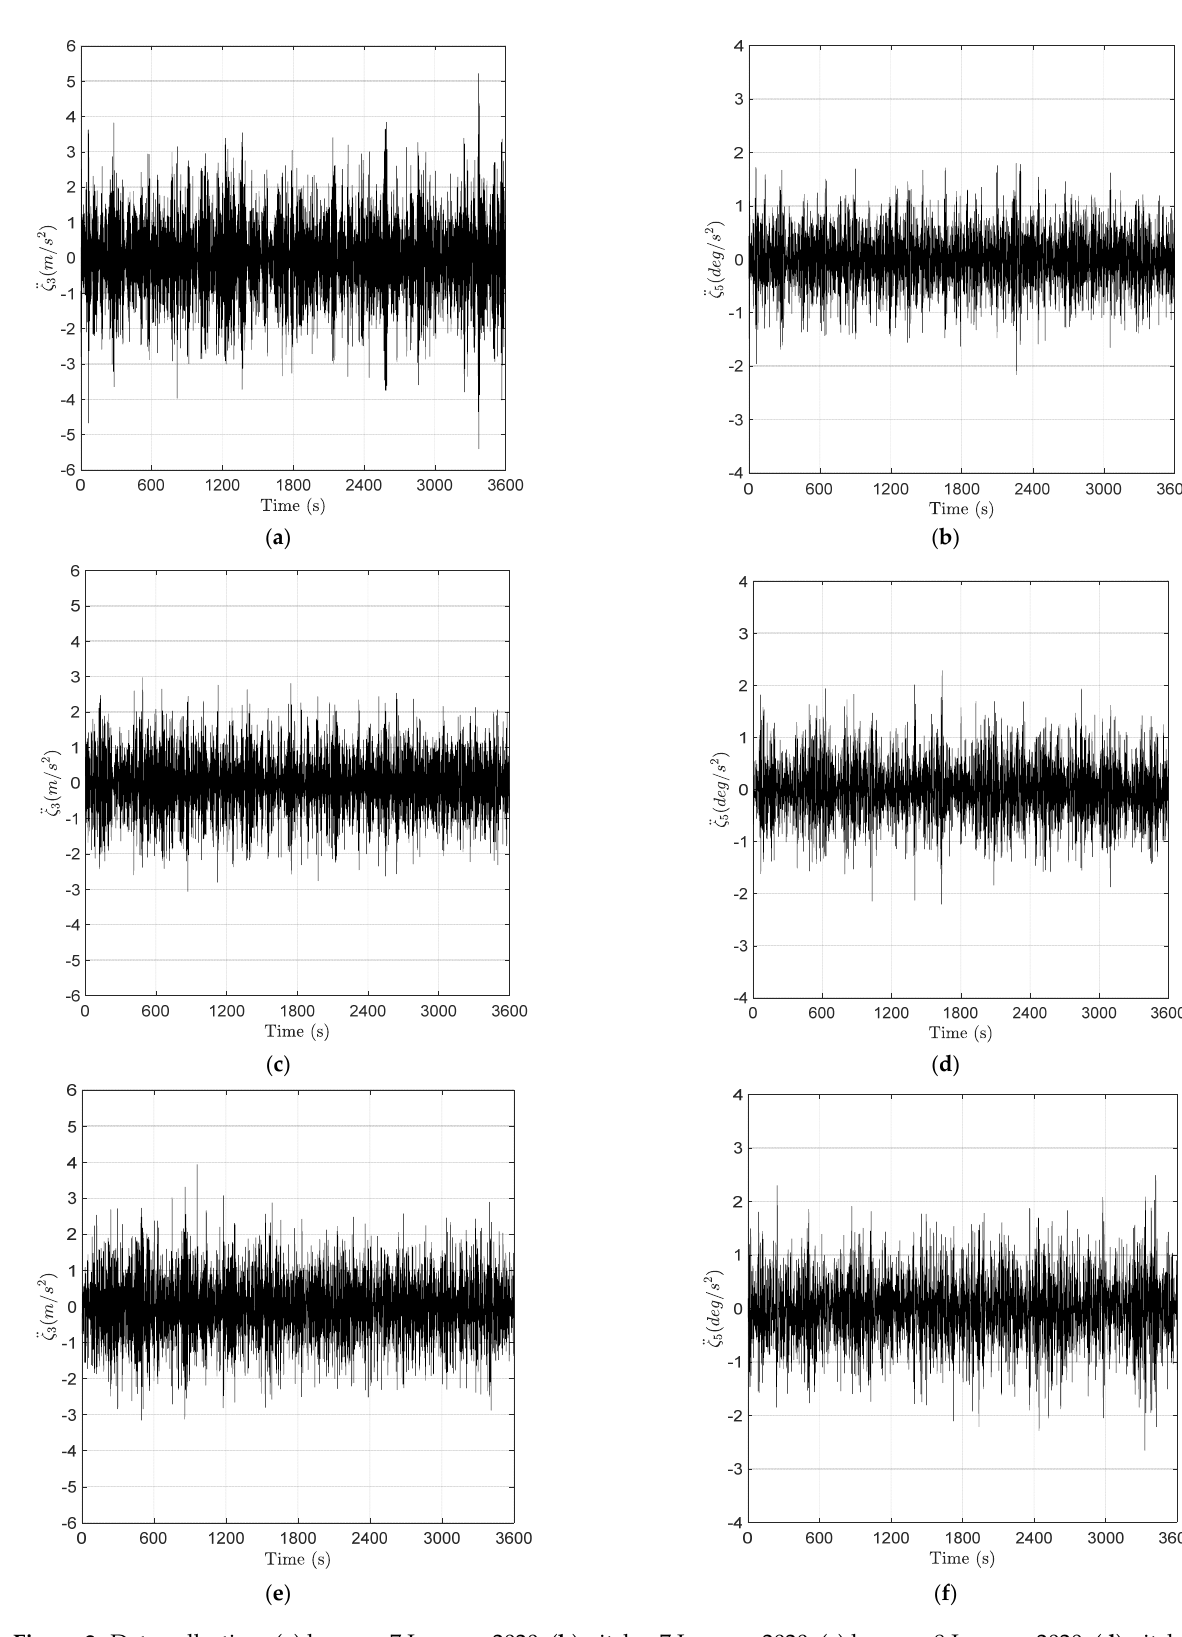
Figure 2 . Data collection: ( a ) heave—7 January 2020; ( b ) pitch—7 January 2020; ( c ) heave—8 January 2020; ( d )